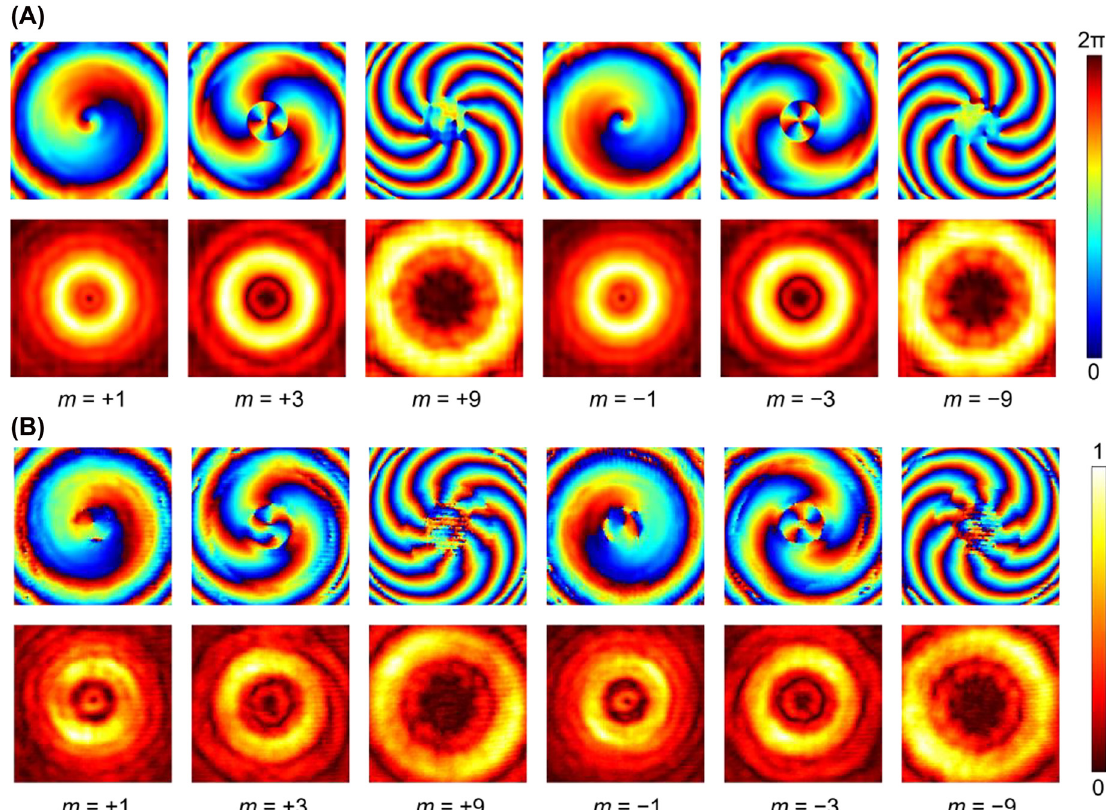
Figure 3: Numerical and experimental characterization of the three BVGs individually. (A) Numerically calculated and(B) experimentally measuredphase pro fi les and amplitudedistributions at 50 GHzin six caseswith m = ± 1, ± 3 and ± 9obtainedusingthreeindividualBVGswithoutcascading. The phasepro fi lesareplotted injetcolorbarandtheamplitudedistributions are plotted in hot